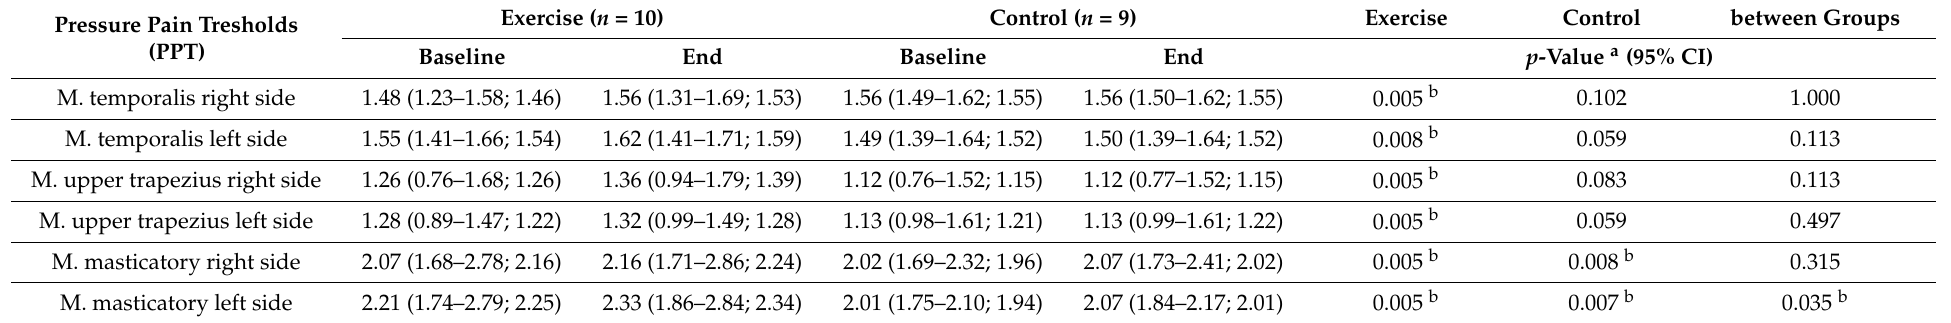
Table 3. Results of pressure pain thresholds (PPT) in